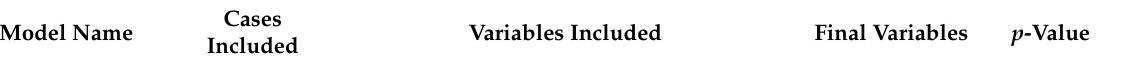
Table 4. Factors independently associated with anxiety and depression and severe psychological